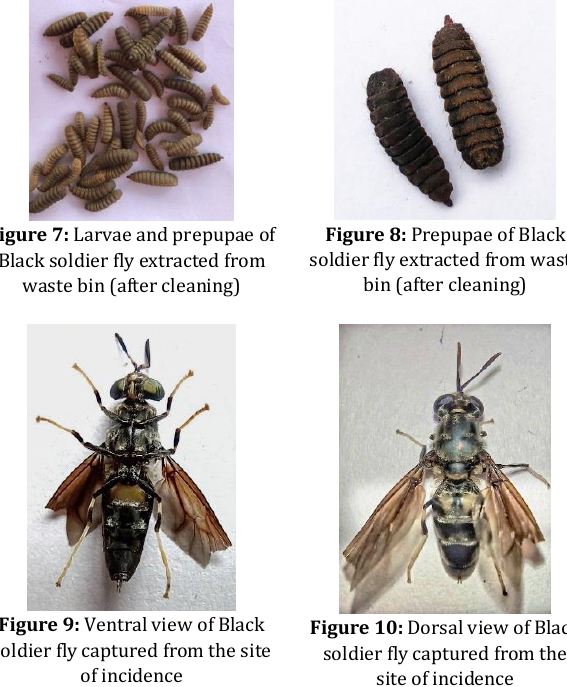
Figure 10: Dorsal view of Black soldier fly captured from the site of incidence